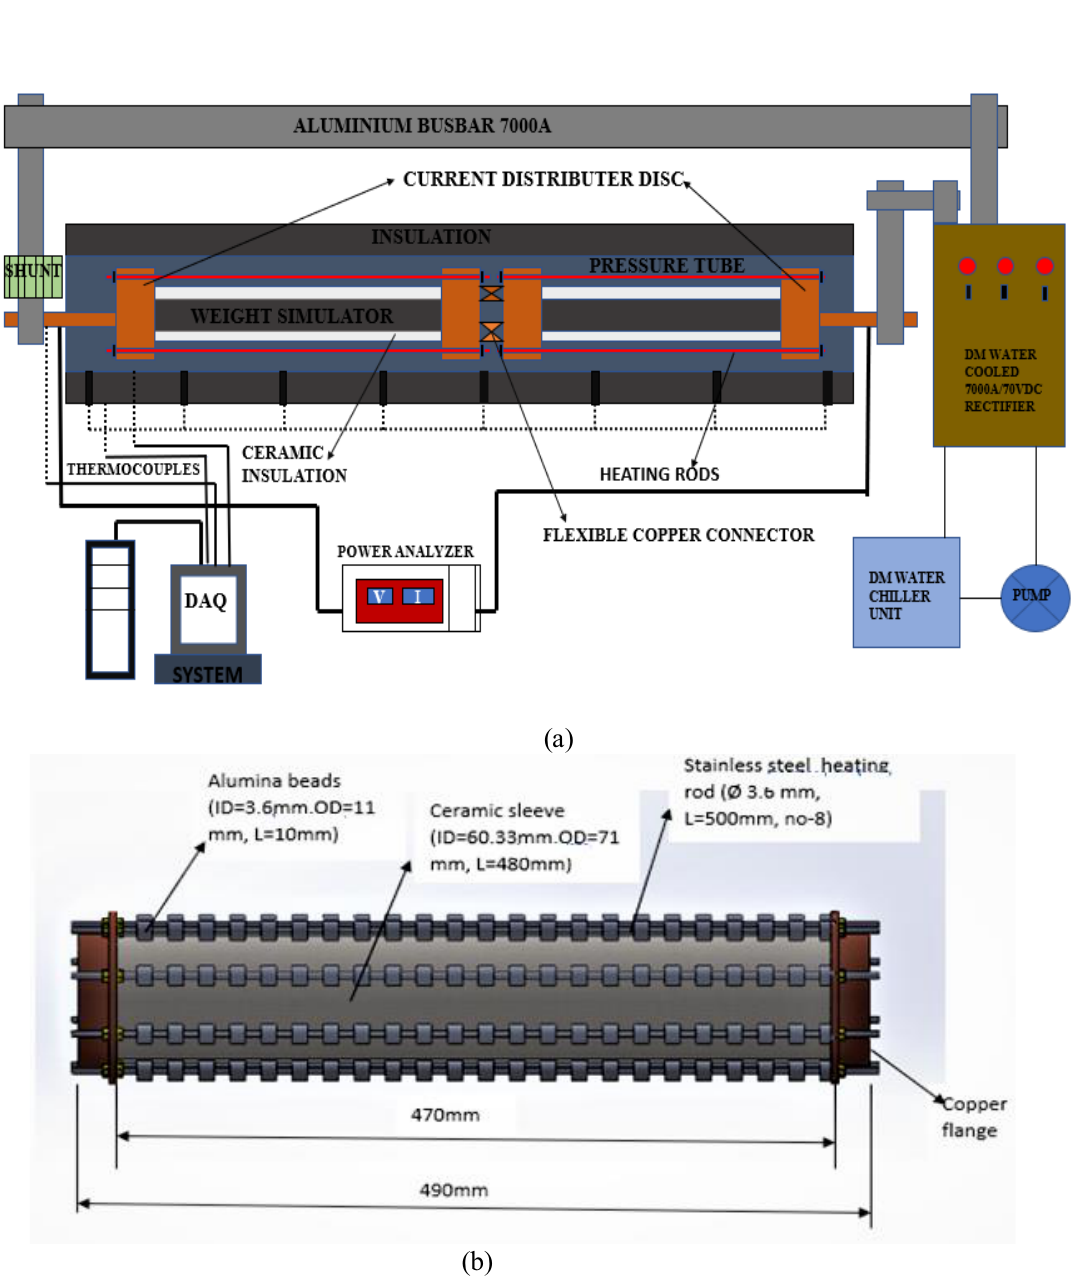
Figure 1. a) Schematic representation of test section b) Fuel bundle weight with